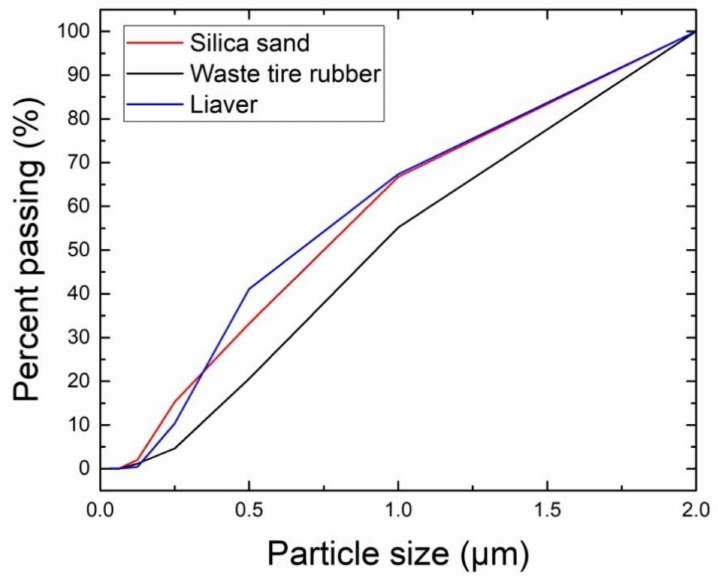
Figure 5. Particle size distribution of silica sand, waste tire rubber, and